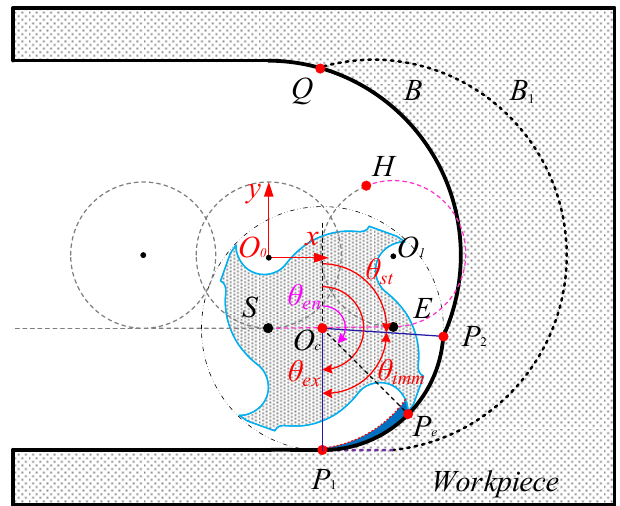
Figure 6. Geometrical relationship in trochoidal milling.